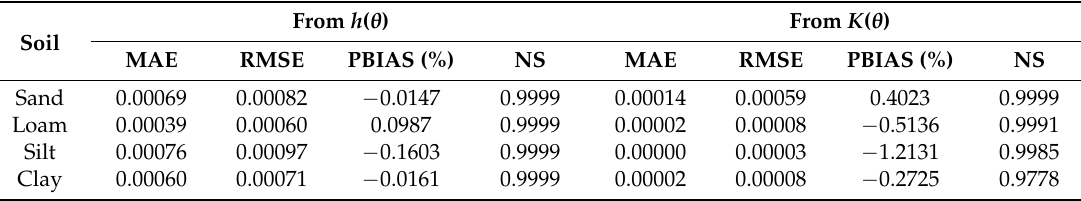
Table 4. Soil water content errors from estimated SWRCs and SWCCs for the four types of soil.